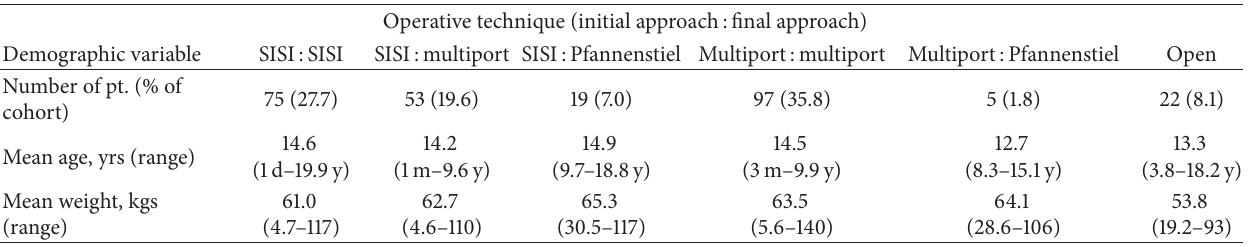
Table 1: Select demographic characteristics of patients with ovarian pathology undergoing operation.